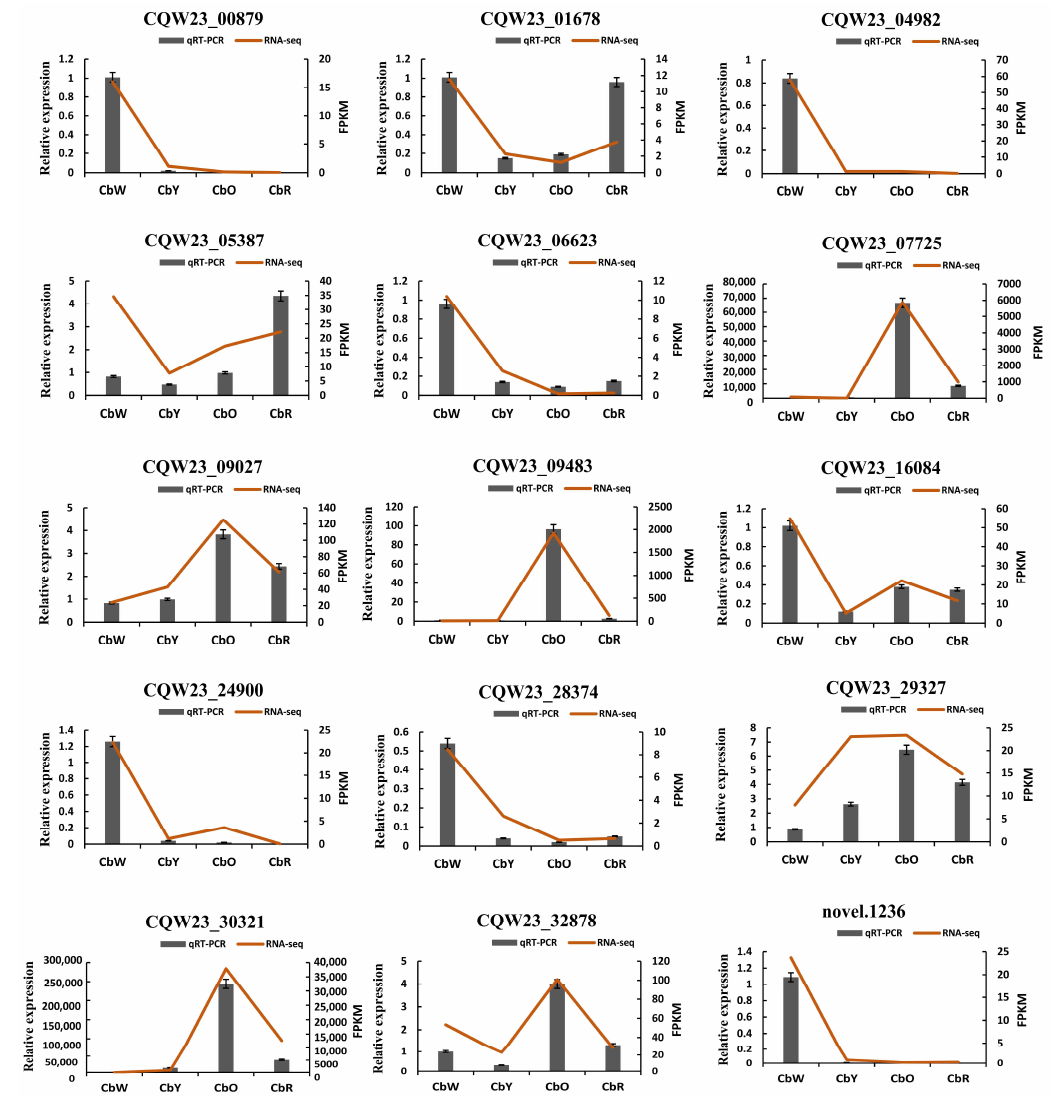
Figure 9. The expression profiles of significantly differentially expressed genes were measured by RNA-seq and qRT PCR. The histogram data indicate qRT-PCR data (left Y -axis), dashed line indicates RNA-seq data (right Y -axis).